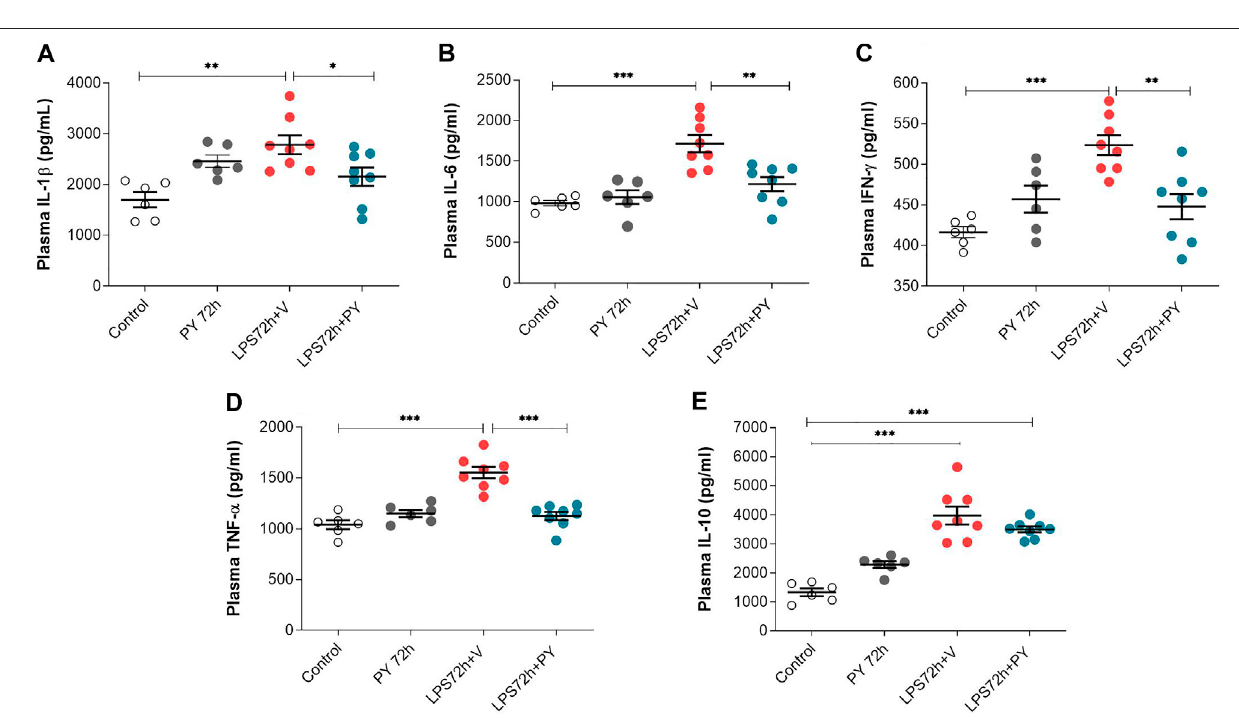
FIGURE8 | Pyridostigmine suppresses plasma cytokine levels in LPS exposed mice at 72 h. (A) IL-1 β , (B) IL-6, (C) IFN- γ , (D) TNF- α , (E) IL-10. *** p < 0.001, ** p < 0.01 and * p < 0.05. Vehicle (V) group (Control), pyridostigmine (PY), lipopolysaccharide (LPS). Values expressed asmean ± SEM. One-way ANOVA followed byTukey ’ s test (See text for